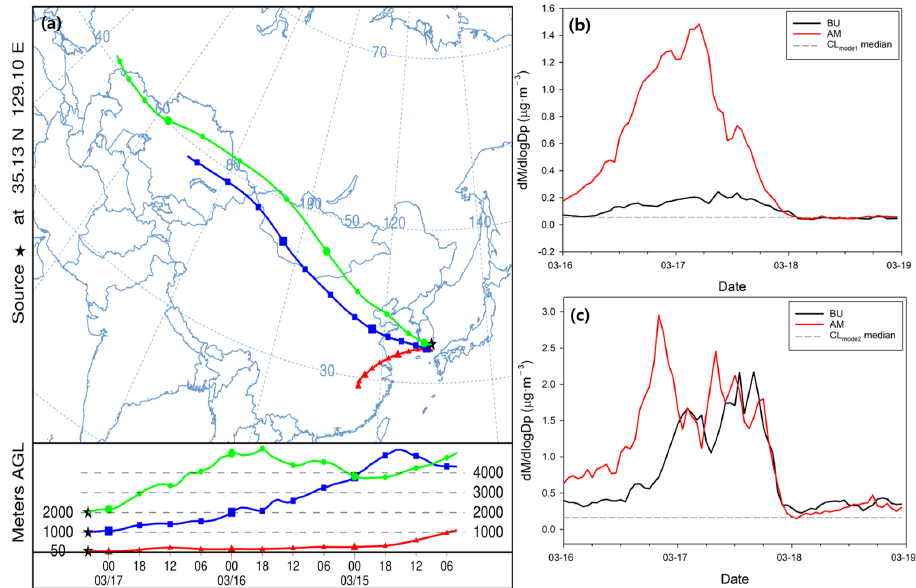
Figure 9. ( a ) Backward trajectory of air masses at 0400 UTC 17 March 2009 in Busan. Time series of aerosol mass concentrations in ( b ) Mode 1 and ( c ) Mode 2 at Busan (black line) are presented with those of Anmyeondo (red line) for 25–26 December 2009. The dashed lines are the median aerosol mass concentration for the CD cases in Modes 1 and 2, respectively.